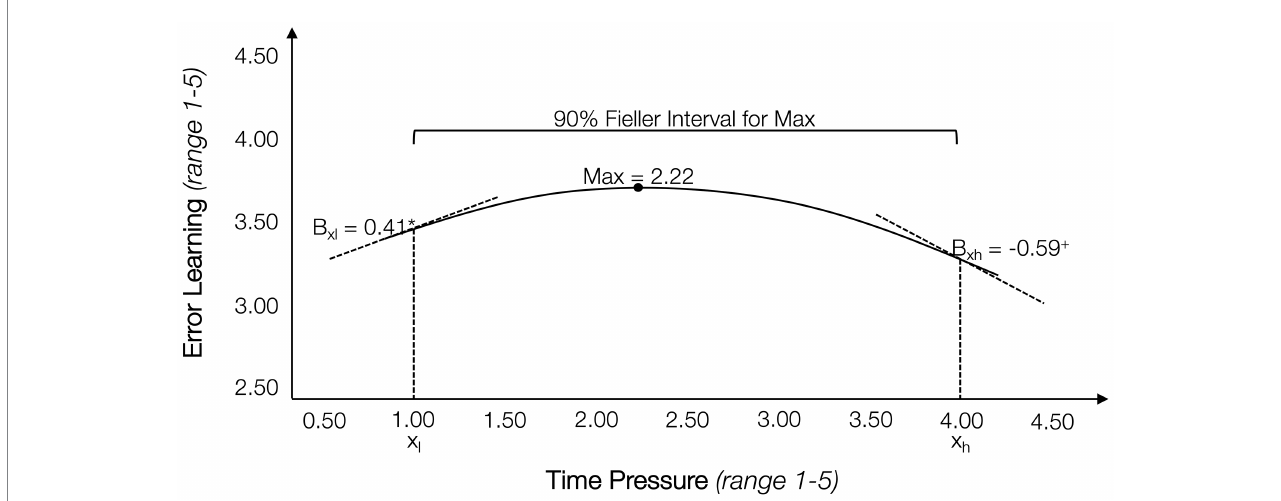
FIGURE 4 Non-linear relationship between time pressure and error learning. N = 141; non-linear relationship tested using Lind and Mehlum's (2010) approach of calculating a 90% Fieller interval around the apex of the function, comparing sign and strength of the slopes at the lower and upper boundaries with a t